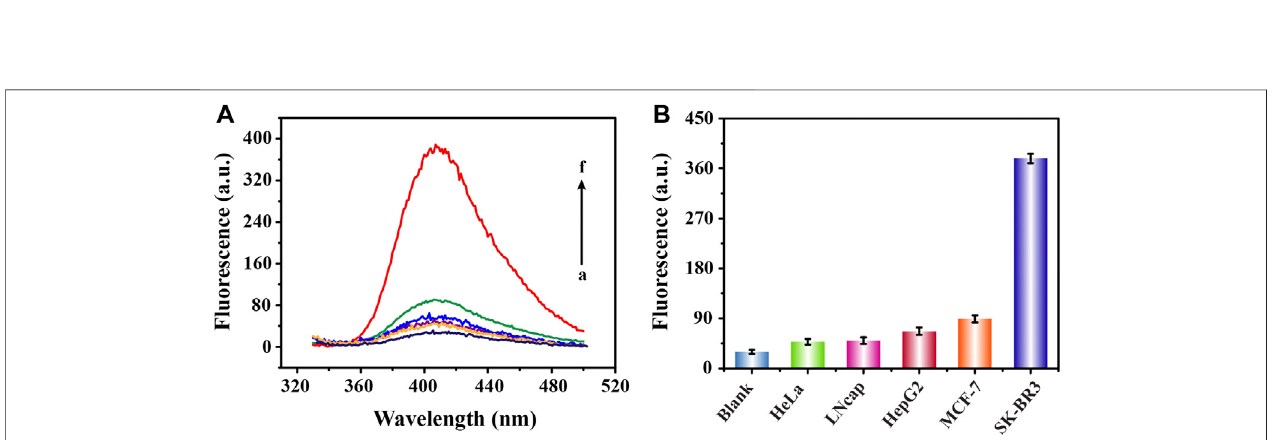
FIGURE 5 | Speci fi c analysis of fl uorescence detection of exosomes derived from different cells. Fluorescence emission spectra (A) and corresponding signal responsediagrams (B) obtainedfromthedetection of fi vecell-derived exosomes (100 × 10 5 particles / ml)(frombtofareHeLa,LNcap,HepG2,MCF-7and SK-BR3cell lines; a represents blank).